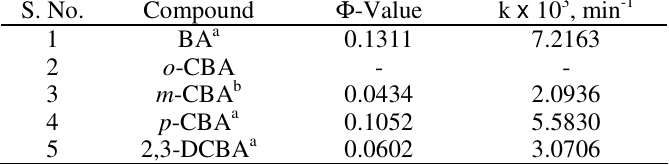
Table 2. Quantum efficiency and rate of dechlorination and decarboxylation S. No.